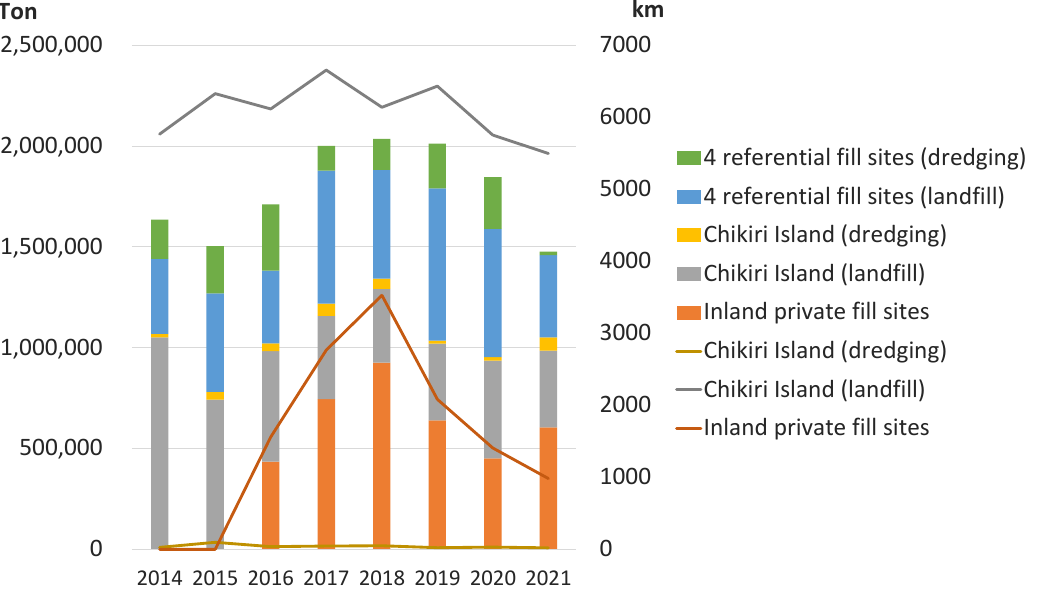
Figure 8. Summary of total fill weights (indicated by bar height) and distances (indicated by line height).